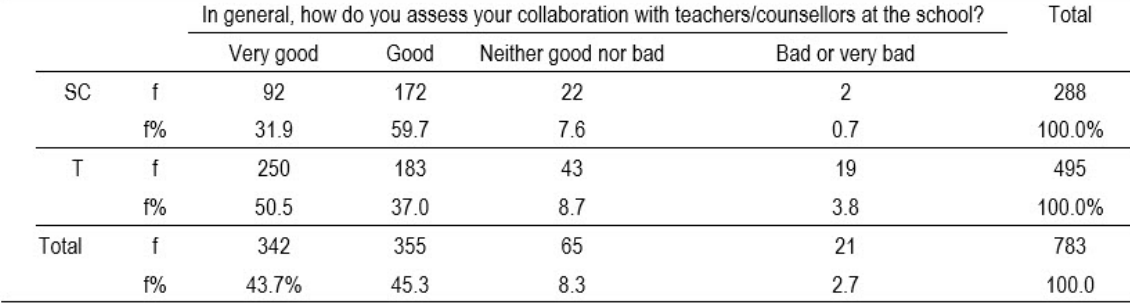
Satisfaction with collaboration as expressed by teachers (T) and school counsellors